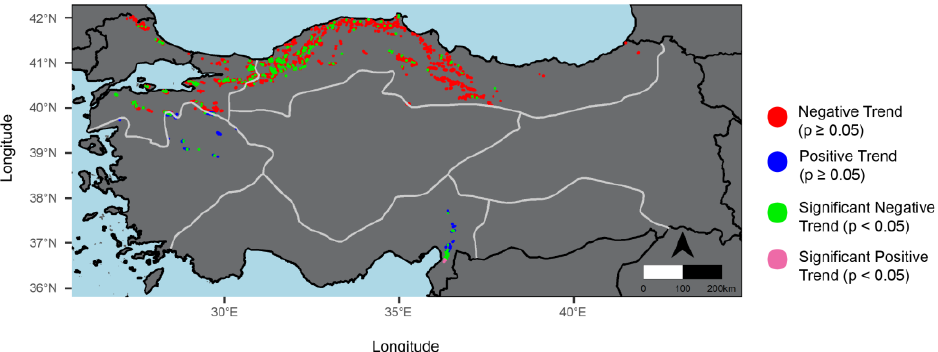
Figure 4. SOS trend directions and significance of individual pixels over the study period (2002 – 2020).